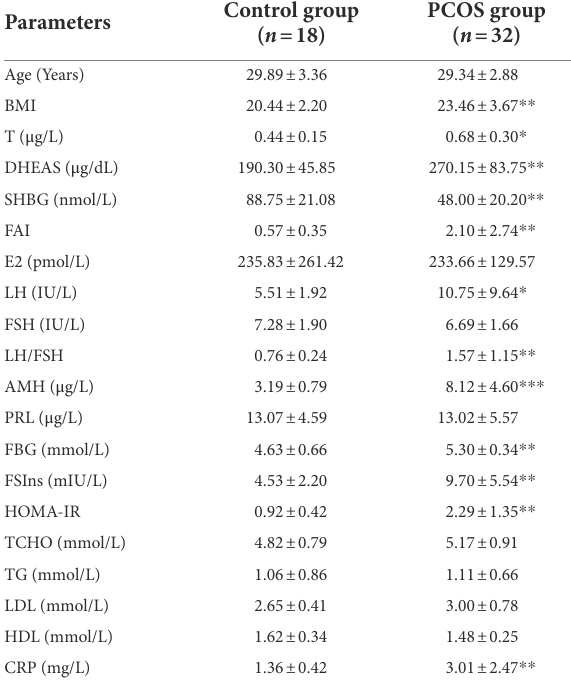
TABLE 1 Clinical baseline characteristics of all